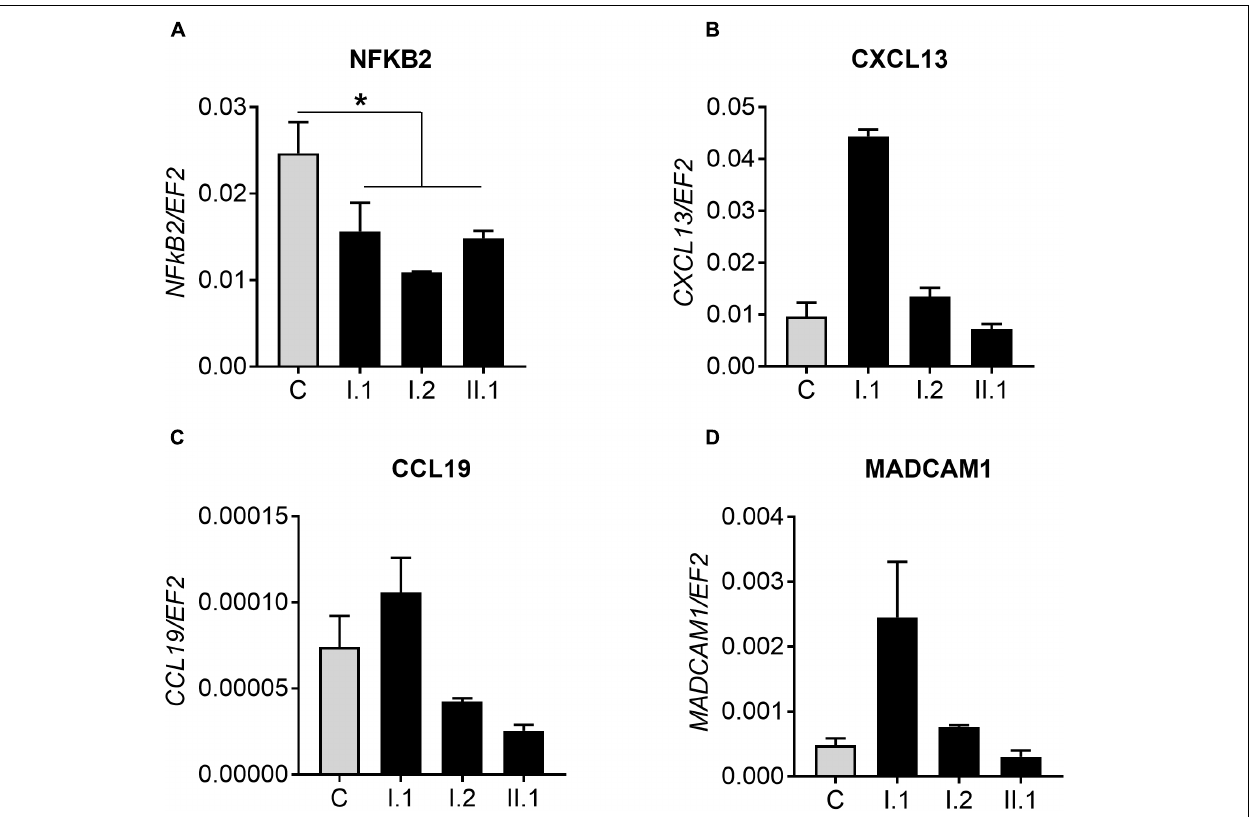
FIGURE 5 | Real-time PCR analysis. (A) Expression of NFKB2 gene in 10 controls (C) and analyzed subjects (I.1, I.2, II.2). Analysis of genes regulated by p100/p52 transcription factor: (B) CXCL13 , (C) CCL19 , and (D) MADCAM1 . ∗ p < 0.05.